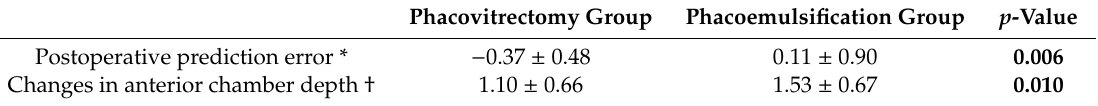
Table 3. Comparison of changes in ocular biometry between the phacoemulsification group and the phacovitrectomy group.